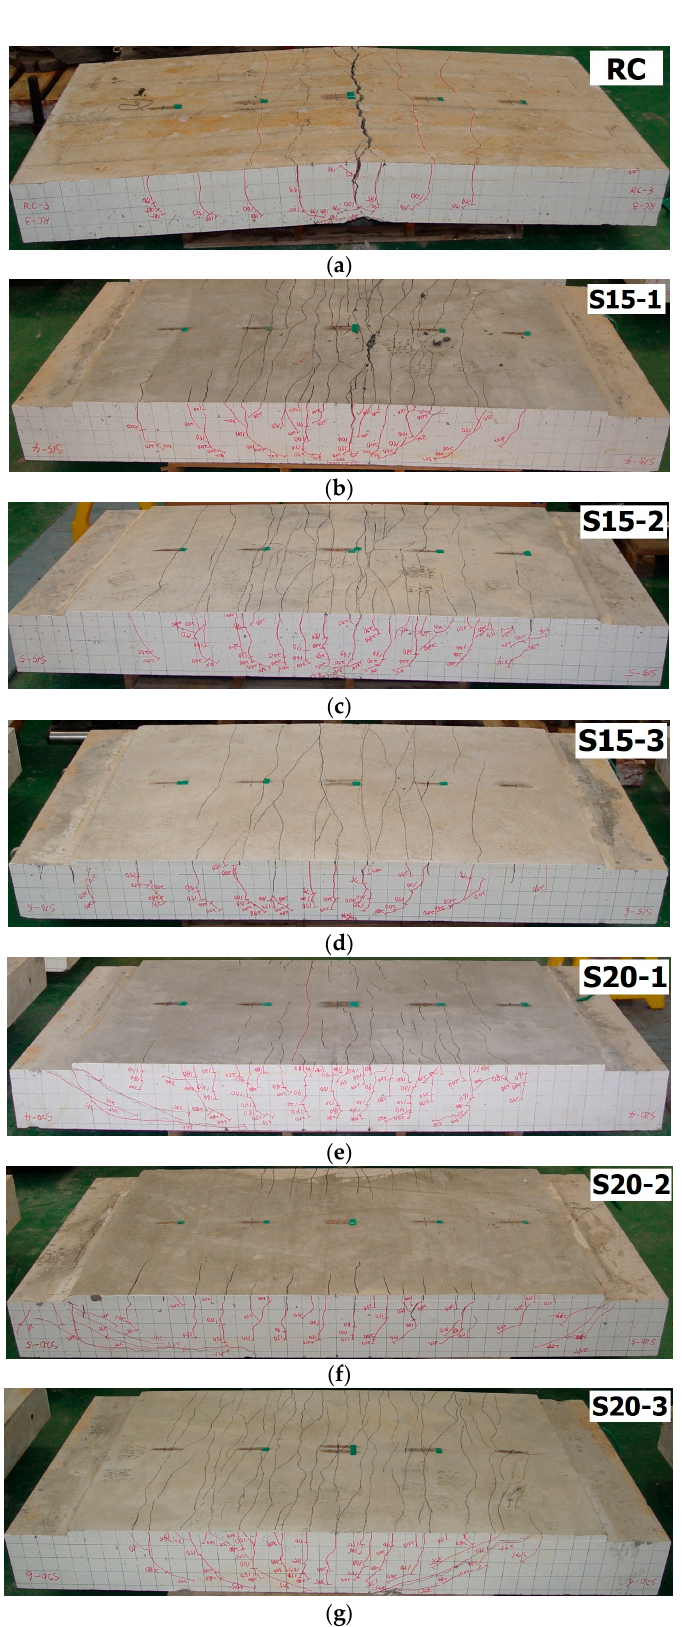
Figure 10. Cracked patterns on the bottom side of specimens after failure (photo). ( a ) RC; ( b ) S15-1; ( c ) S15-2; ( d ) S15-3; ( e ) S20-1; ( f ) S20-2; ( g )